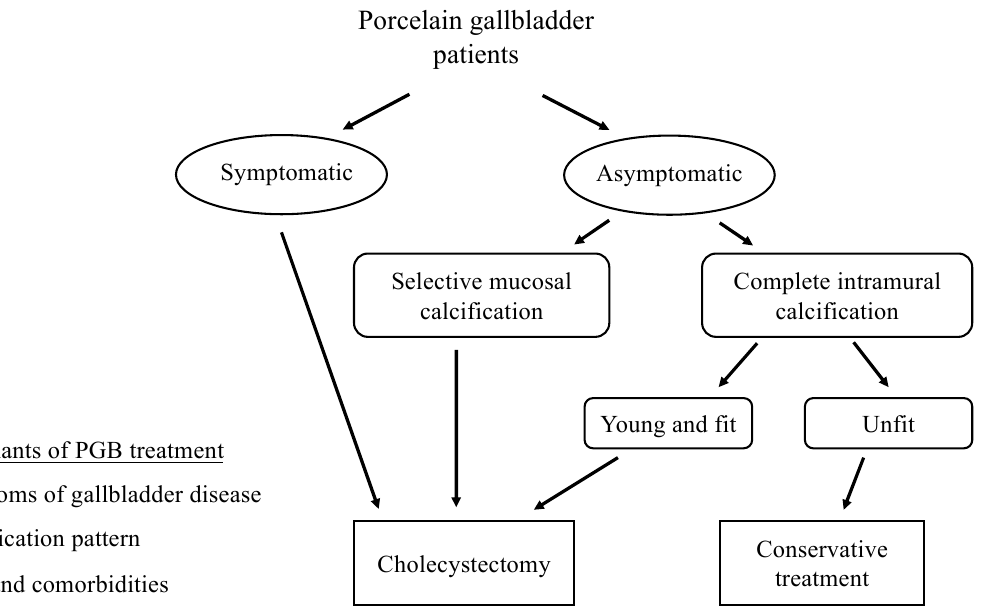
Figure 1. Management of porcelain gallbladder patients.